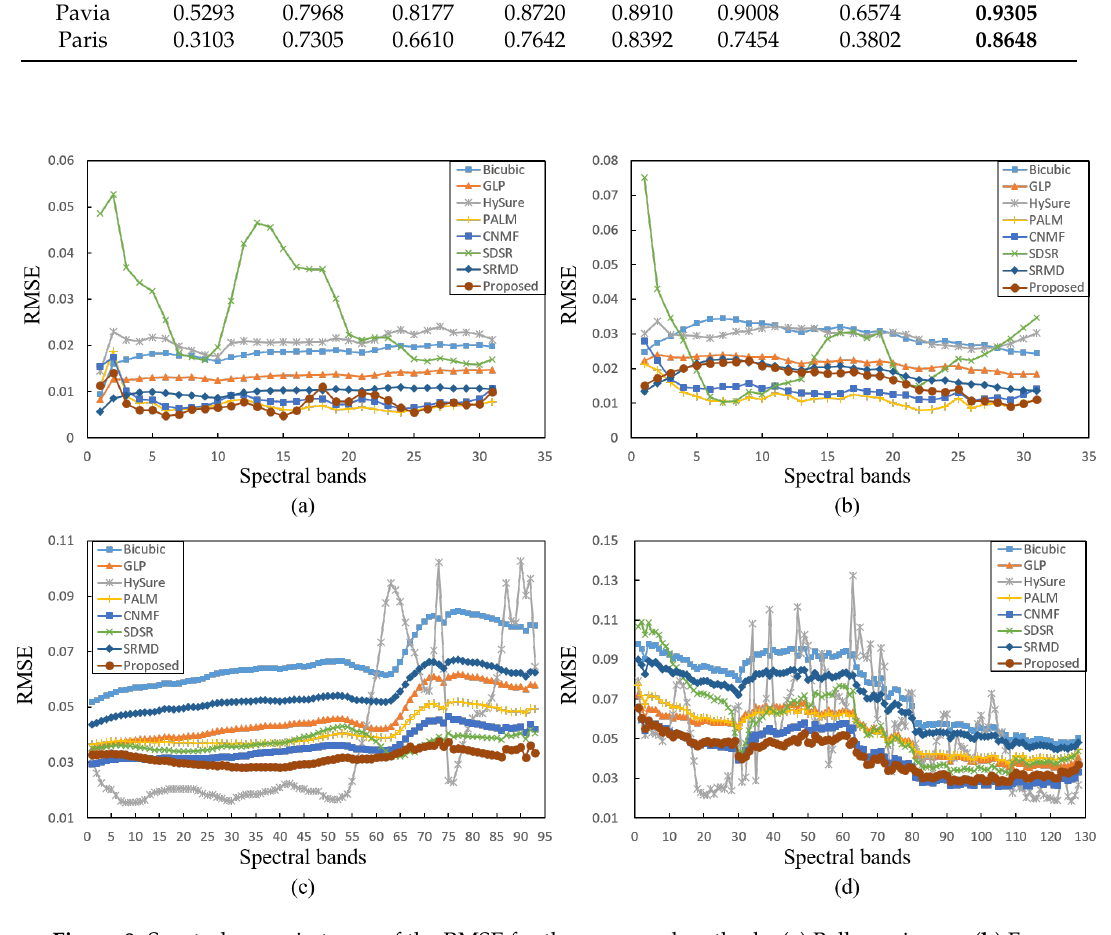
Figure 9. Spectral errors in terms of the RMSE for the compared methods. ( a ) Balloons image; ( b ) Face image; ( c ) Pavia image; ( d ) Paris image. Table 5. The average values and the standard deviations of the RMSEs corresponding to Figure 9, in terms of percentage